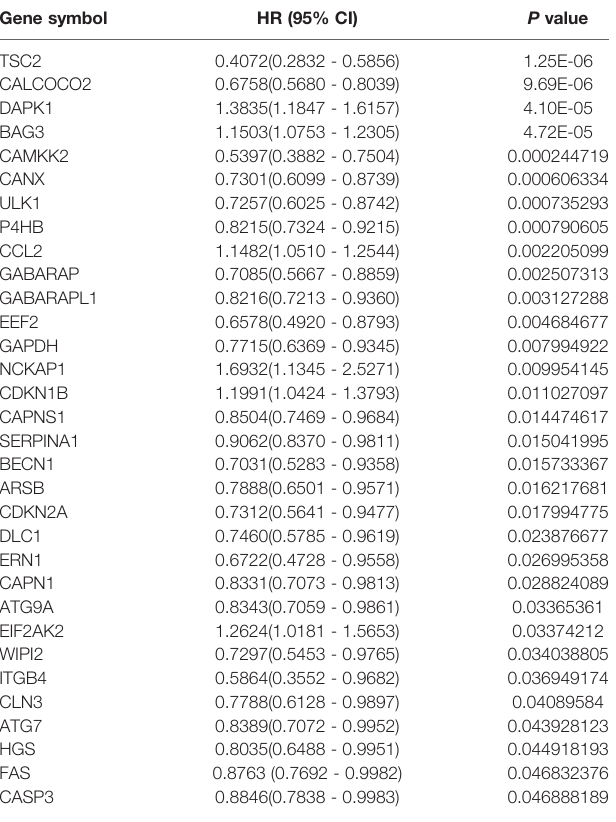
TABLE 1 | Overall survival-related ARGs in the AML patients ( P <